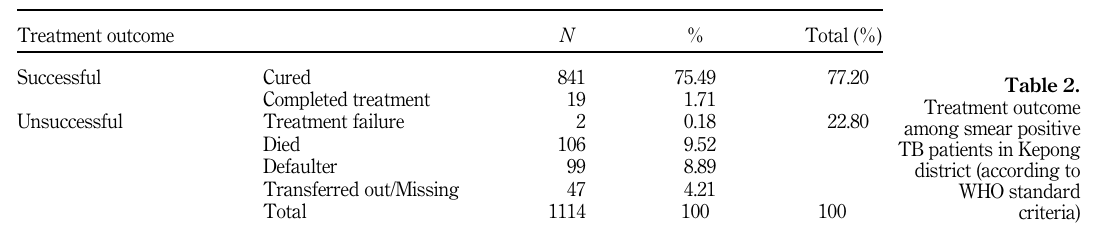
Table 2. Treatment